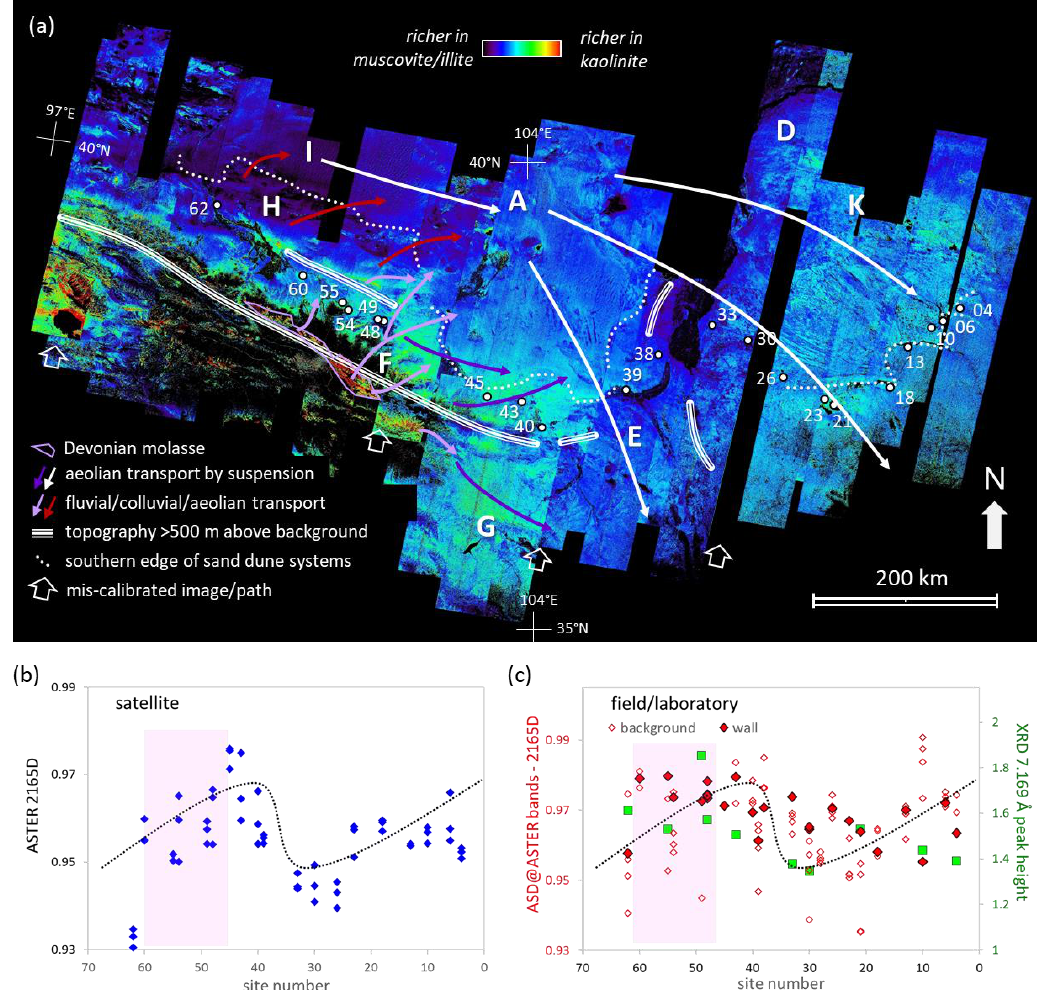
Figure 6. ( a ) Satellite ASTER 2165D index base-map depicting the proportion of kaolin (warmer tones) versus white mica (cooler tones). ( b ) Scattergram of the west-to-east spatial trend of satellite ASTER 2165D ROI responses. ( c ) Scattergram of the west-to-east spatial trend of field 2165D responses of both wall (filled red circles) and background (open red circles) samples. These are underlain by laboratory XRD results of the 7.169 Å kaolinite peak height (green boxes) for selected wall samples. A magenta box highlights the well- preserved “Shandan” wall section.